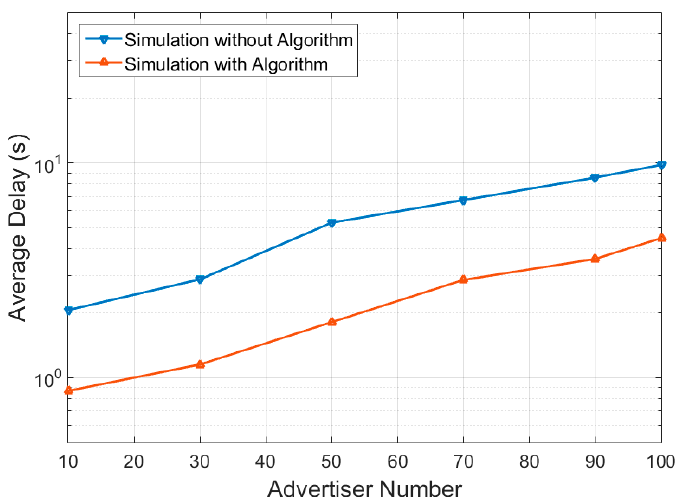
Figure 14. Average delay for advertiser discovery by the initiator in the worst-case scenario.